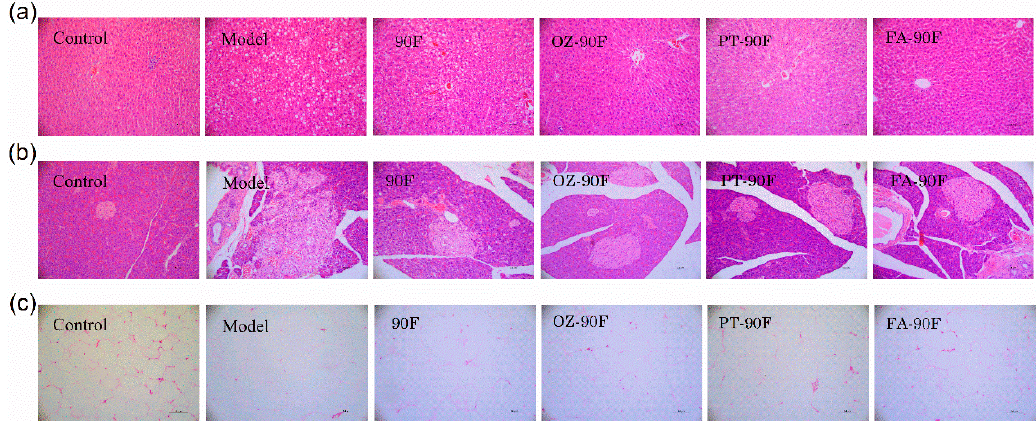
Figure 8. Histological examination. At the end of the study, the rats were dissected and the liver ( a ), pancreas ( b ) and epididymal fat ( c ) were collected for histological examination. Representative samples were stained with hematoxylin and eosin. The bar represents 94 µ m. 90F, 90% wheat flour; OZ-90F, γ -oryzanol enriched 90% wheat flour; PT-90F, phytosterol enriched 90% wheat flour; FA-90F, ferulic acid enriched 90% wheat